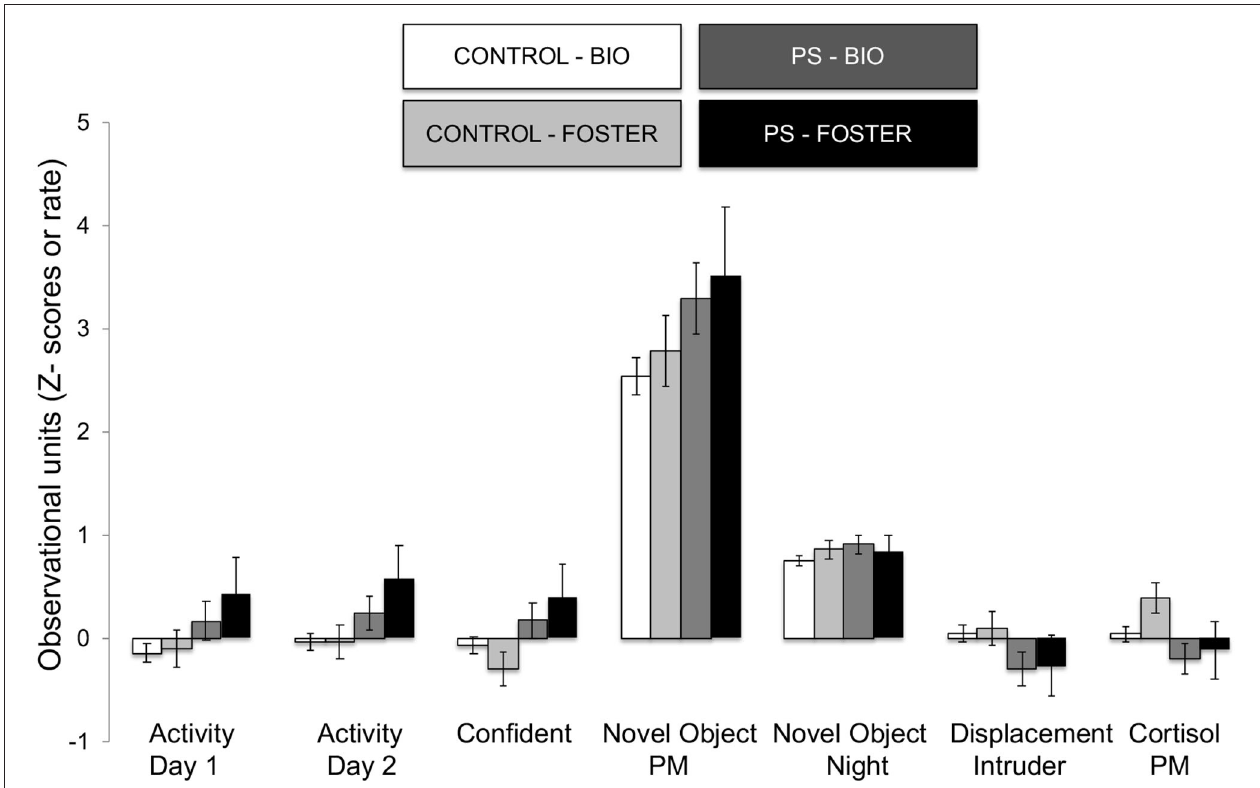
FIGURE 5 | Effects of prenatal stress on significant temperament measures during biobehavioral assessment in biologically reared and cross-fostered infants. Means are presented ± standard error of the mean. CONTROL = No prenatal stress ( n = 149) PS = Prenatal Stress ( n = 39), BIO = infants raised by biological mothers ( n = 146), FOSTER = infants raised by unrelated foster mothers ( n = 42). p <